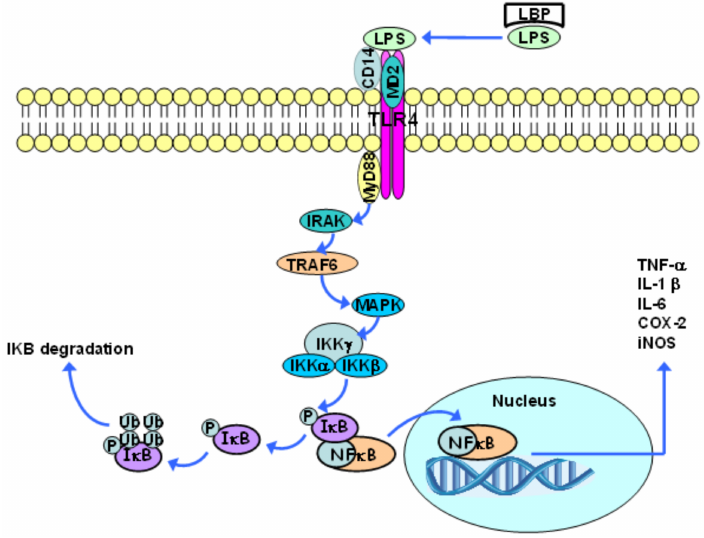
Figure 2. Toll-like receptor 4 (TLR4) induced signaling activates the transcription factor NF κ B. LBP: LPS-binding protein; LPS: lipopolysaccharides; IRAK: IL-1 receptor associated kinase; TRAF6: TNF receptor associated factor 6; MAPK: mitogen activated protein kinase; IKK: inhibitor of nuclear factor kappa-B kinase; iNOs: inducible nitric oxide